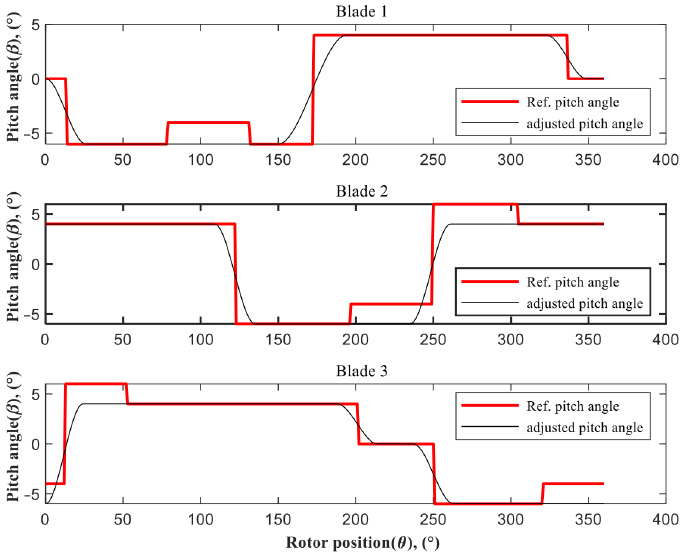
Figure 9. Original and adjusted reference pitch angles.